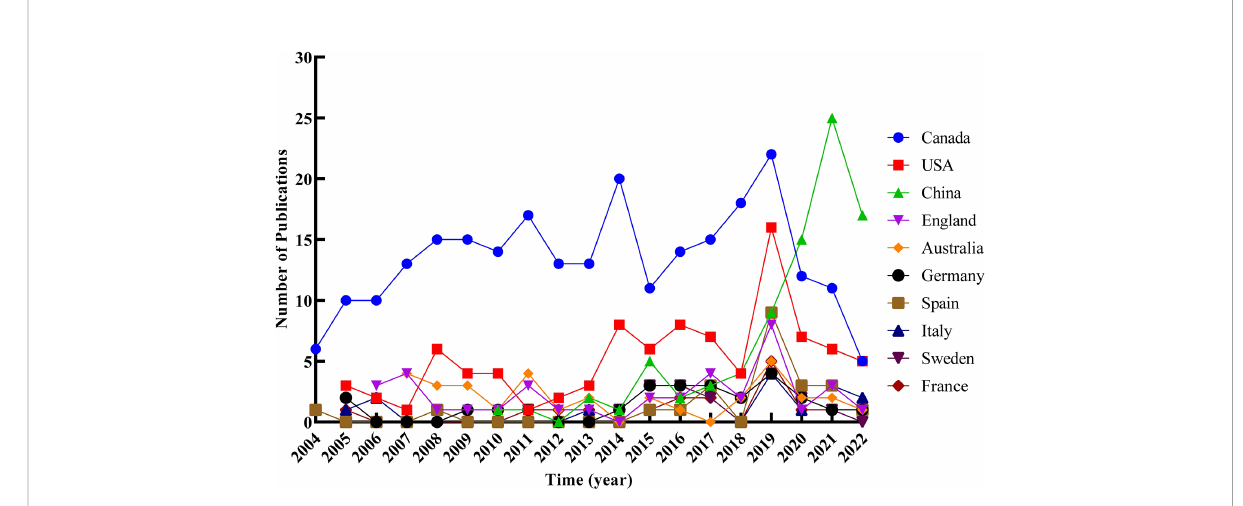
FIGURE 4 Trends of annual publications of the top 10 countries/regions related to RNA methylation in DM and its